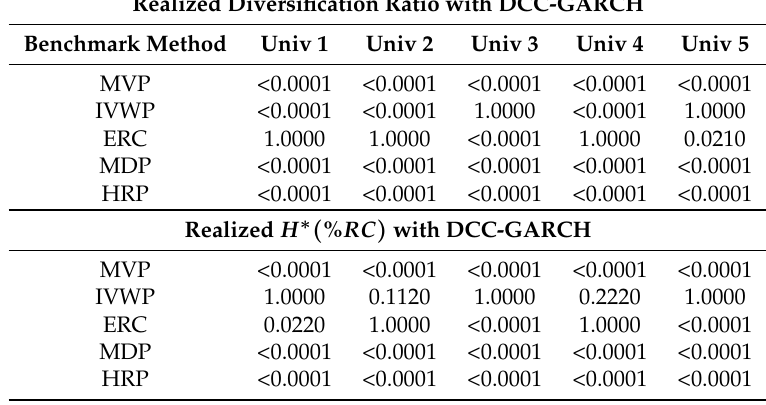
Table 7. p c -values for different choices of portfolio allocation benchmark models when DCC-GARCH is used for estimating the covariance matrix and the portfolio is rebalanced